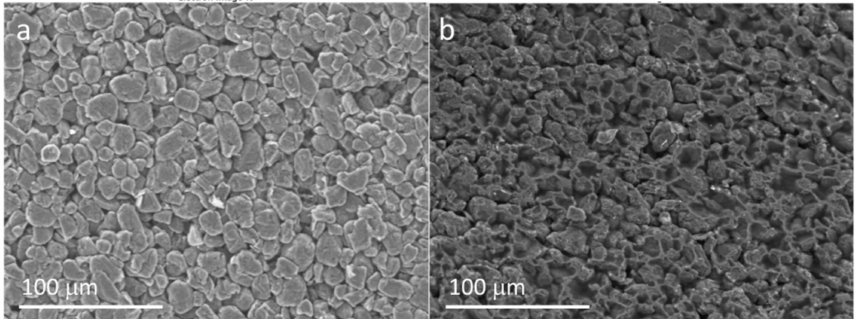
Figure 7. SEM images of anode black mass for ( a ) QC rejected cell and ( b ) EOL cell. Both electrodes have been washed in IPA ( a ) is the surface of the electrode nearest the separator and ( b ) is towards the current